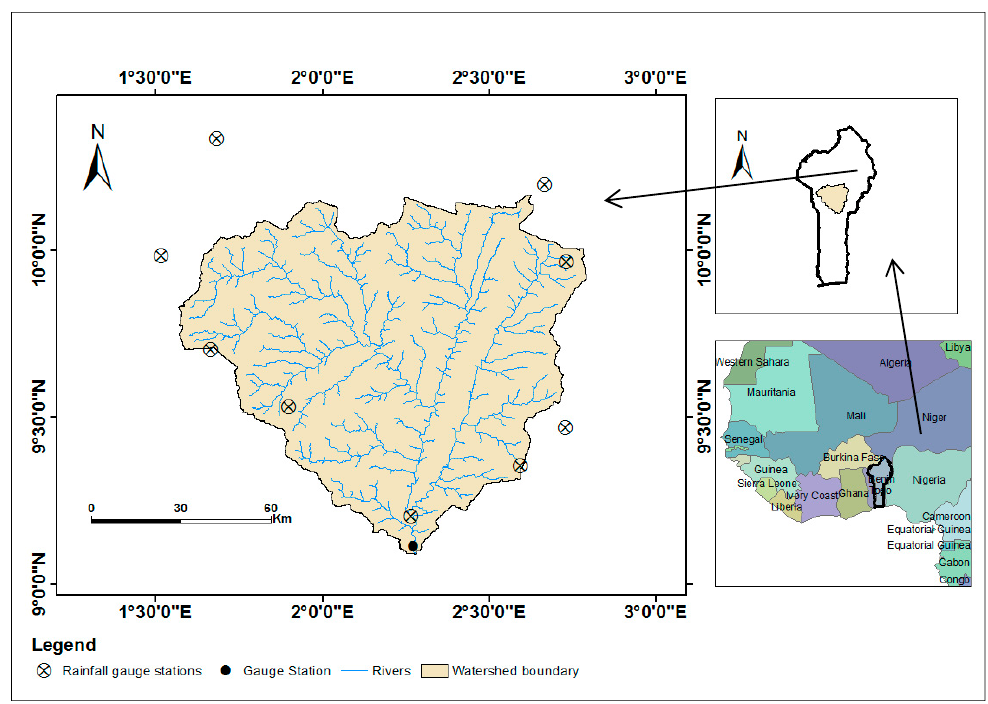
Figure 1. Catchment of the Bétérou River.